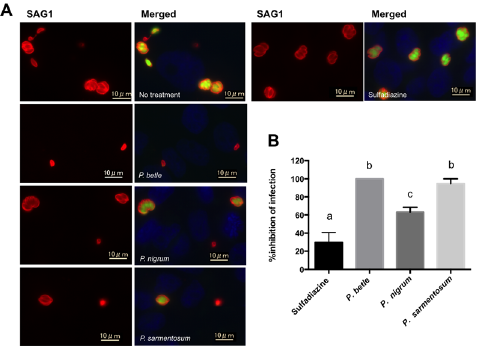
Fig 2. Effects of the three piperaceae extracts at 25 μ g/mL and sulfadiazine at 1 mg/mL on extracellular T . gondii . The RH-GFP line, pre-treated with either of the extracts ( P . betle , P . nigrum or P . sarmentosum ) or sulfadiazine for 1 h, was then used to infect vero cells. After 24 h, the infected cells were analyzed by IFAT to measure the infection rates. (A) Representative images of T . gondii RH-GFP-infected vero cells. The cells were treated with either P . betle (25 μ g/mL), P . nigrum (25 μ g/mL), P . sarmentosum (25 μ g/mL) extract or sulfadiazine (1 mg/mL). SAG1, red; GFP, green; nucleus, blue. (B) The % inhibition of infection for RH-GFP was measured by counting the number of SAG1-positive vero cells per 100 vero cells. Each bar represents the mean ± SD of three wells per group. The results represent two independent experiments. The different letters above the data bars in the graphs indicate statistically significant differences as determined by a one-way ANOVA plus Tukey – Kramer post-hoc analysis ( P < 0.05).